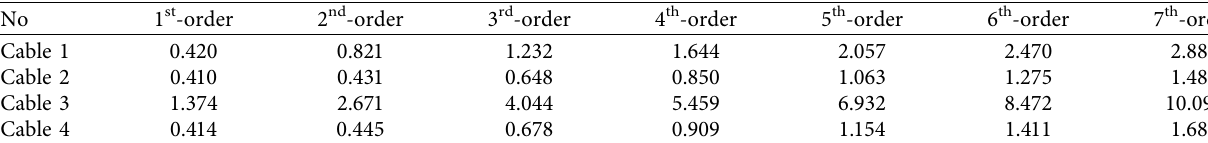
Table 3: Accurate modal frequencies of the four cables